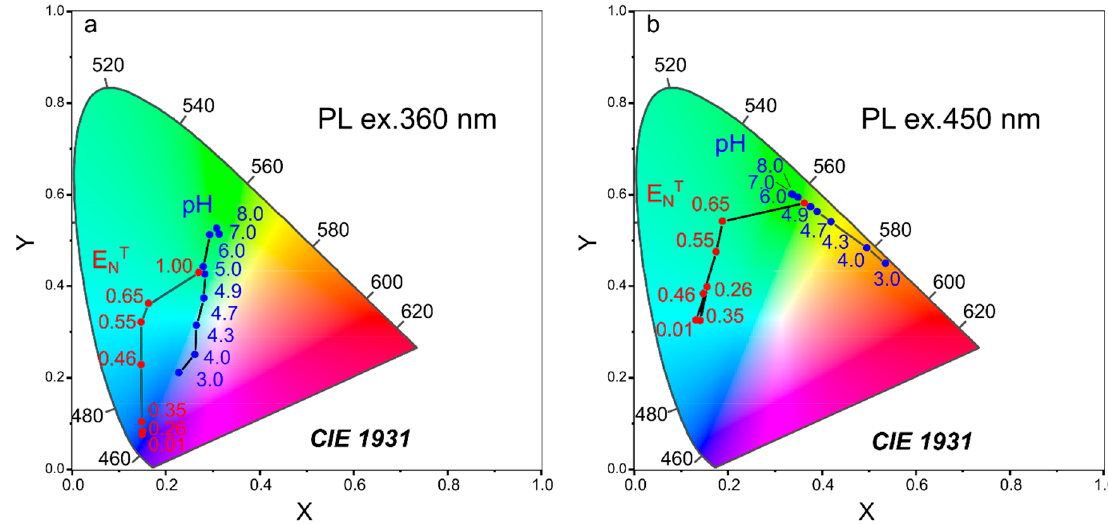
Figure 5. CIE diagram representing the changes in the emission spectrum of CD-w with changing solvent polarity (E T , red circles) and pH (blue circles) of CD aqueous solutions. Excitation wavelengths: 360 nm ( a ) and 450 nm ( b ).